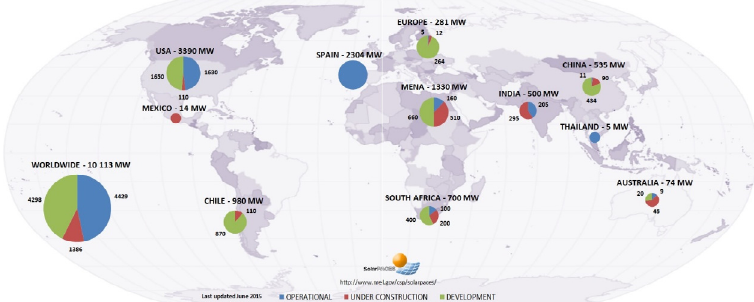
Fig. 3. Accumulated capacity of Concentrating Solar Power